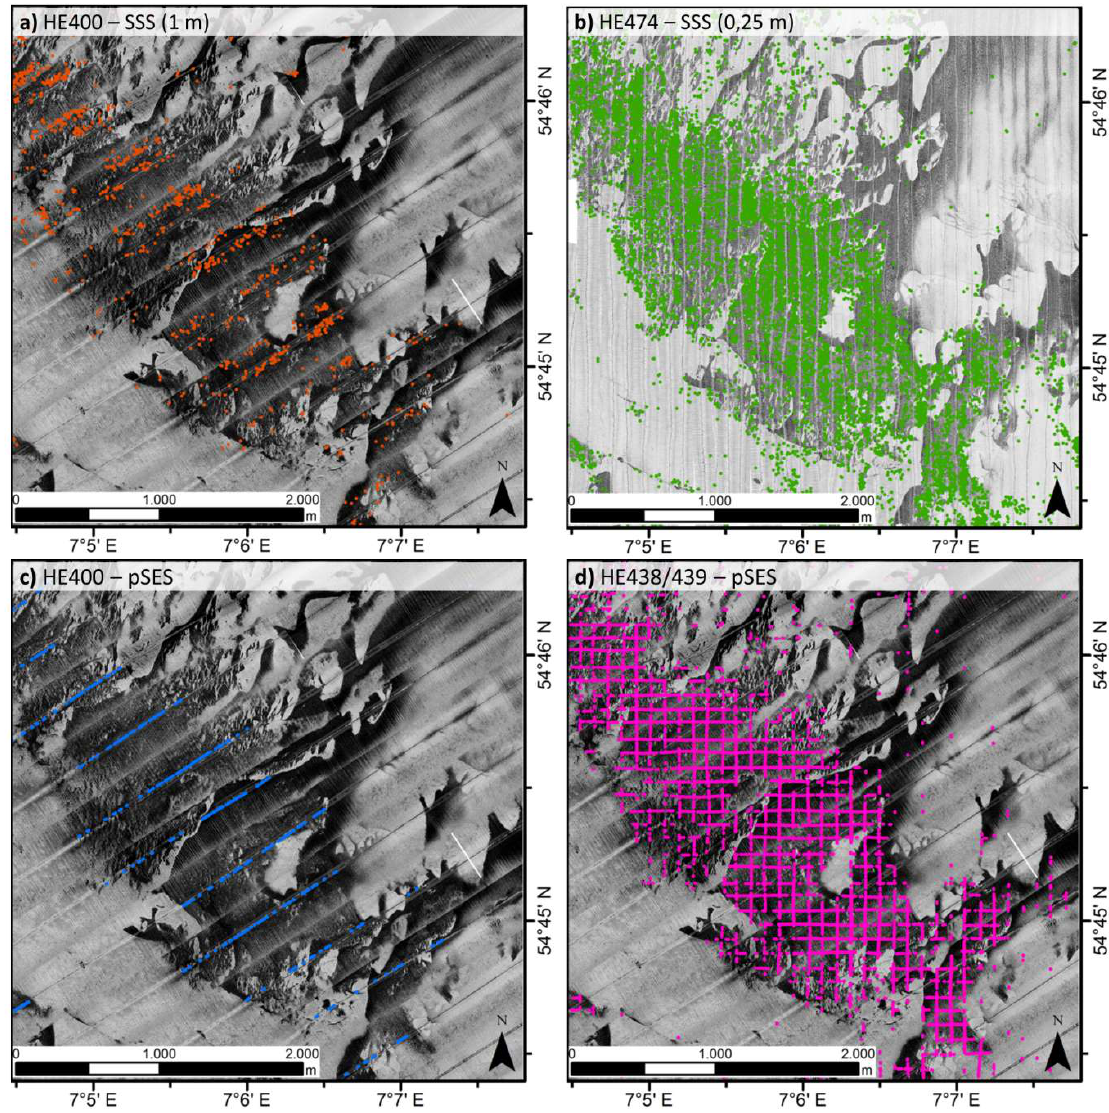
Figure 4. Stone observations using different techniques: ( a ) manually tagged on the low resolution SSS backscatter mosaic, ( b ) manually tagged on the high resolution SSS backscatter mosaic, ( c ) hyperbola extraction from pSES survey with track distance of 400 m (NE-SW), ( d ) hyperbola extraction pSES survey with track distance of 100 m (N-S and E-W). Dark colors in the SSS mosaic represent high backscatter and bright colors low backscatter values.